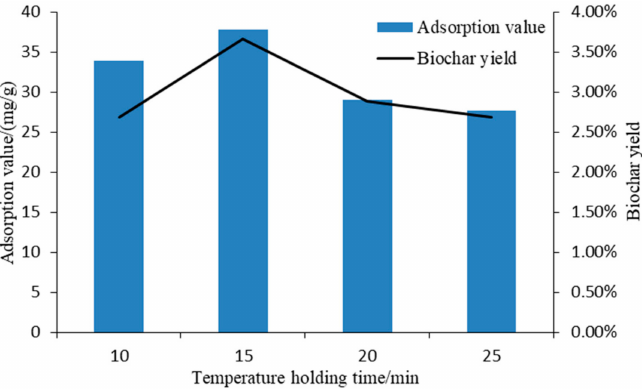
Figure 5. E ff ect of holding time on the biochar yield and